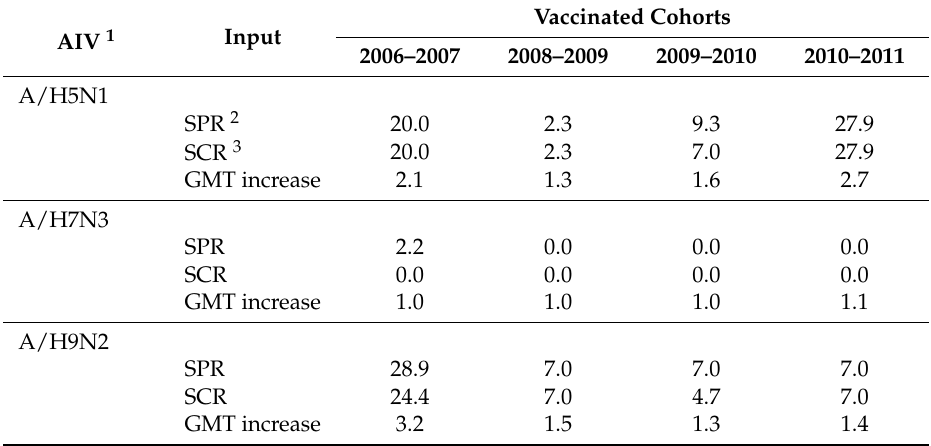
Table 4. Values of seroprotection rate, seroconversion rate, and geometric mean titer increase against avian influenza viruses after trivalent influenza vaccination in each vaccine campaign